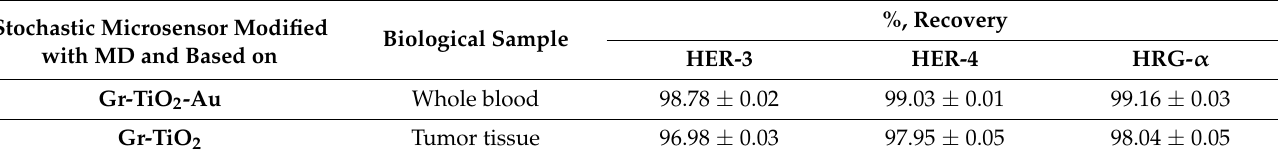
Table 5. Recovery of HER-3, HER-4 and HRG- α in whole blood and tumoral tissue